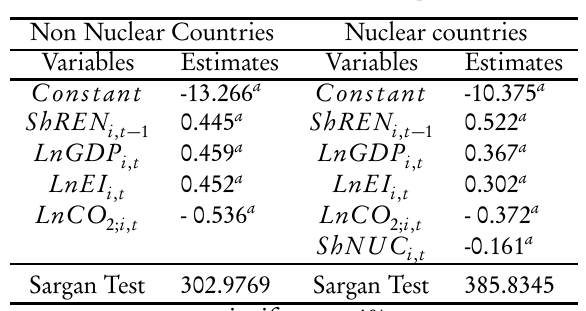
Regression Results in the two